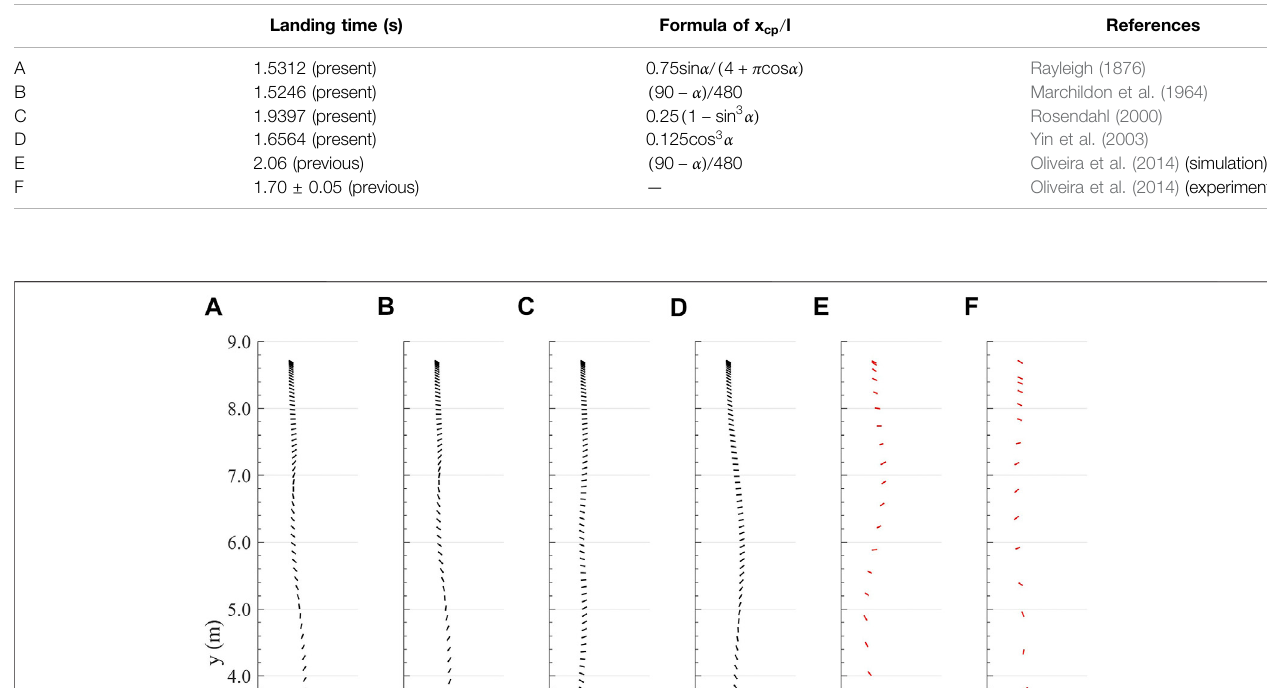
Frontiers in Mechanical Engineering |